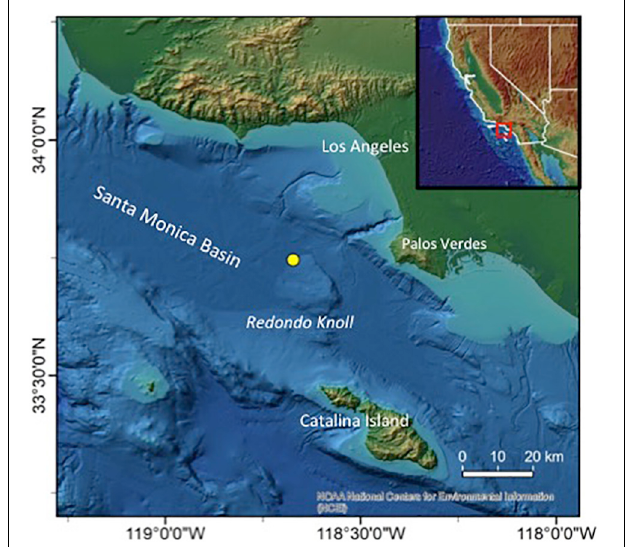
FIGURE 1 | Study location. Inset overview map (upper right) shows the location of our study area within the California Borderlands region, SW United States. The larger map (seafloor topography derived primarily from satellite altimetry) shows the Redondo Knoll , ∼ 30 km offshore from Palos Verdes (CA), north of Catalina Island, and at the south east limit of the Santa Monica Basin. Triton , the cold-seep site discussed in this paper, is located at the base of Redondo Knoll , on its NW side, at ∼ 900 m depth (yellow circle).